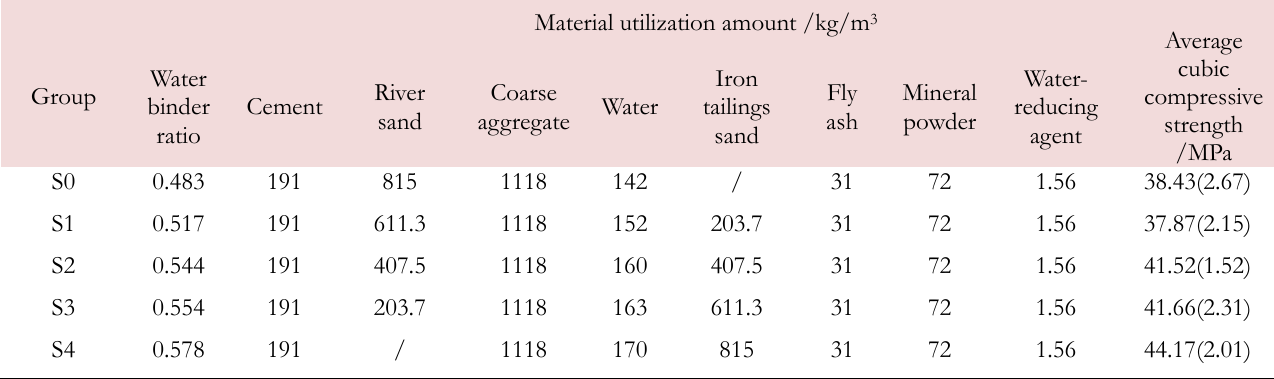
Table 2: Mixture proportions of concrete and compressive strength (standard deviations in parentheses).